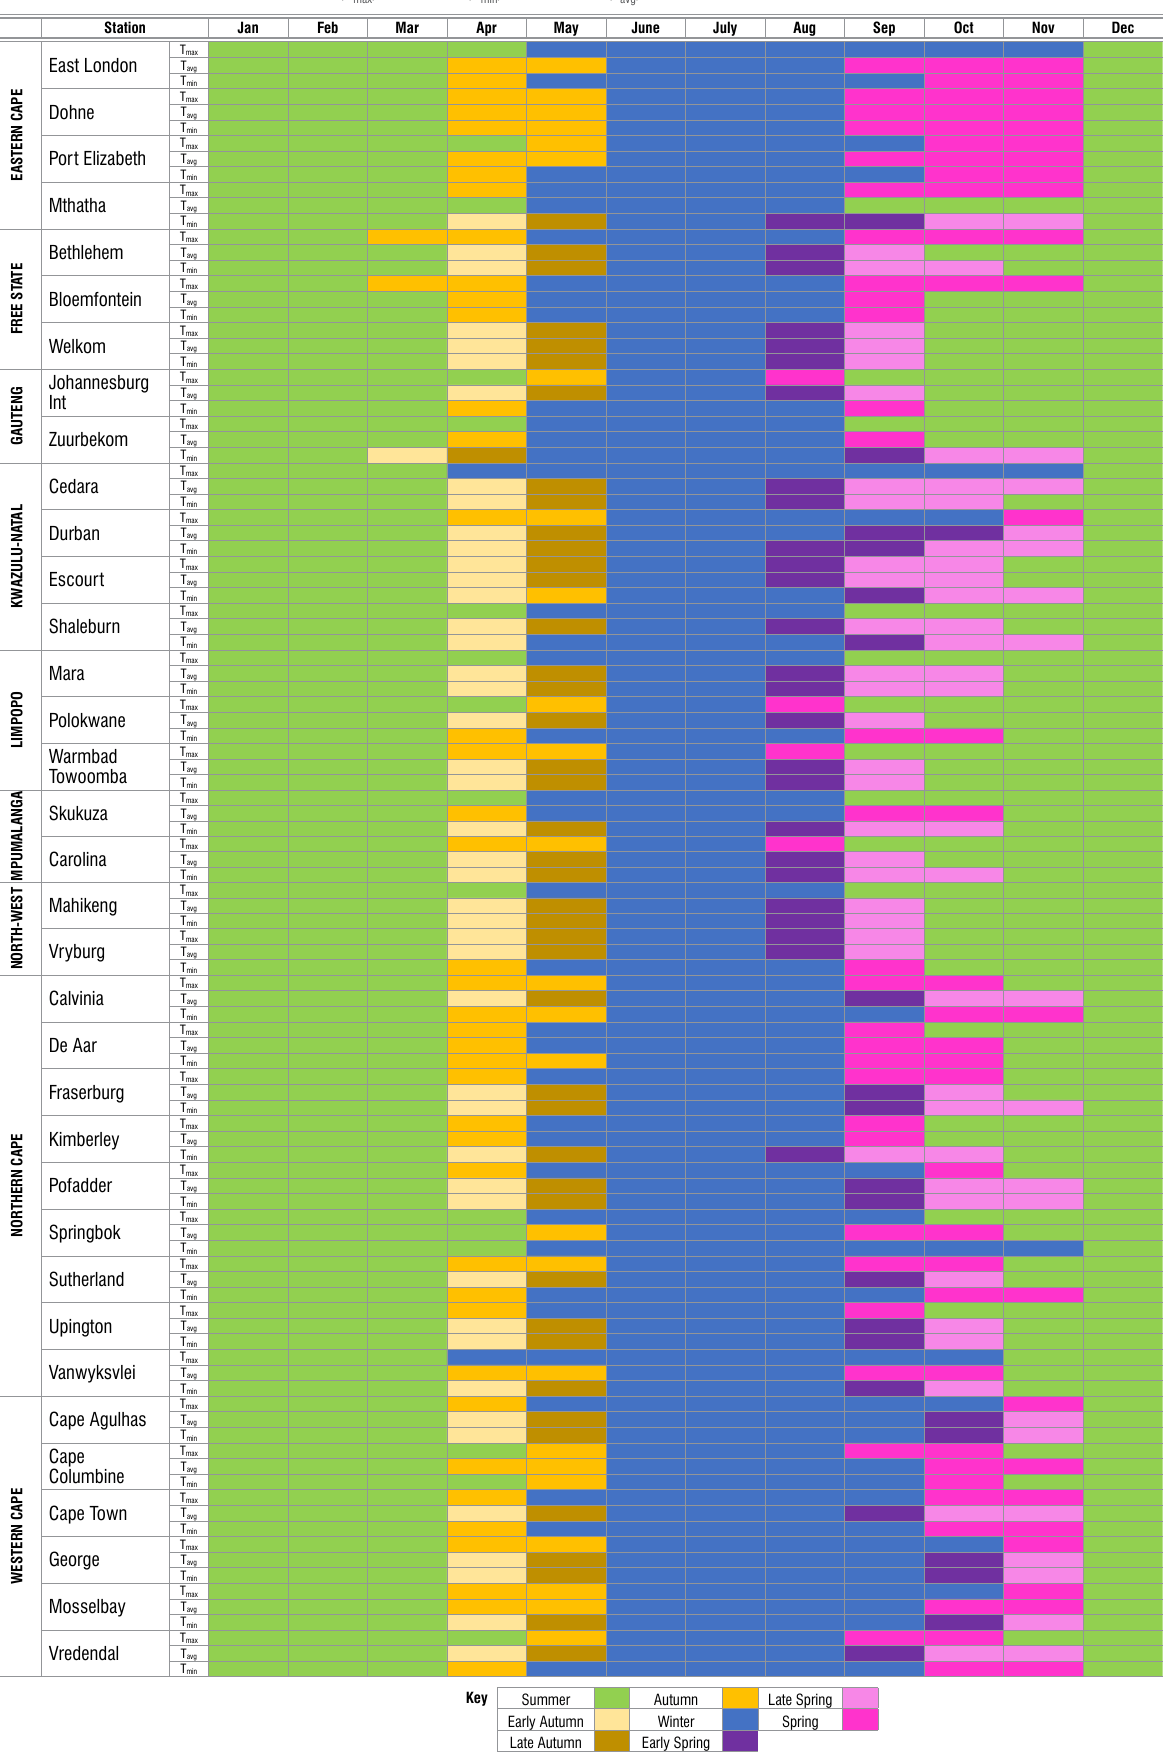
), minimum (T ) and average (T ) temperatures max min avg